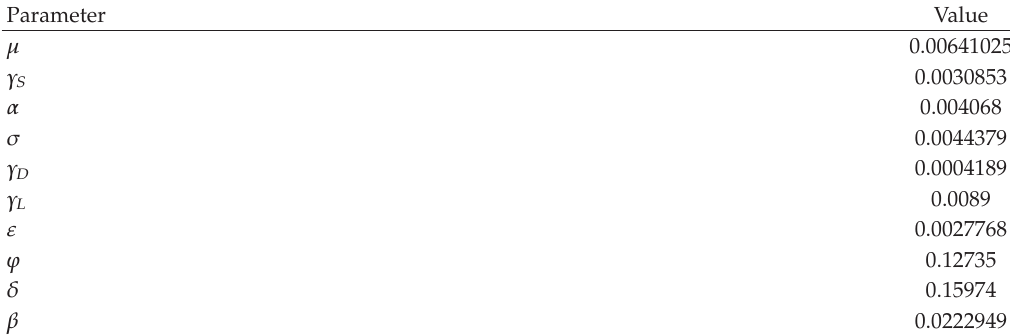
Table 1: Parameters (cid:3) week scale (cid:6) of the model given for the nonlinear ordinary di ff erential equation system (cid:3) 3.4 (cid:6) for the region of Valencia, Spain.